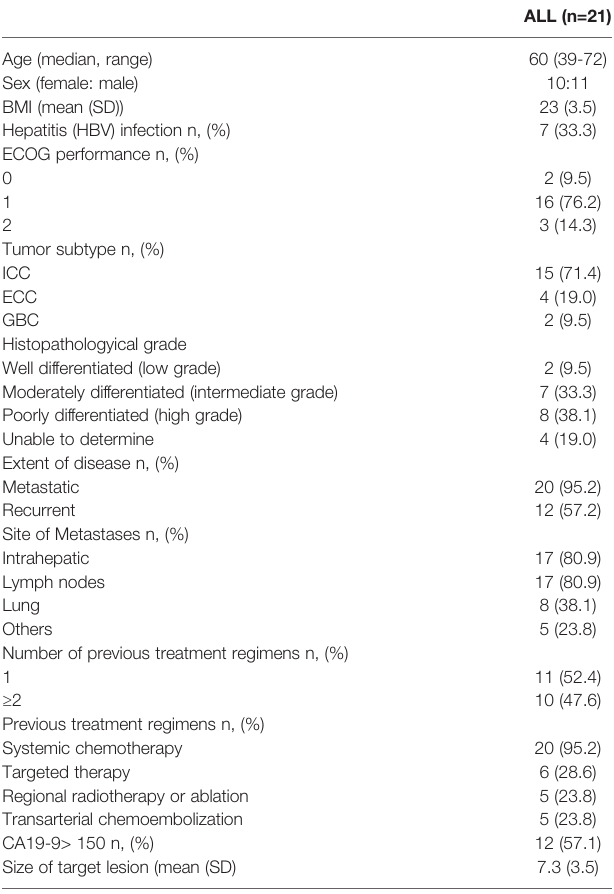
TABLE 1 | Patient baseline demographics and disease